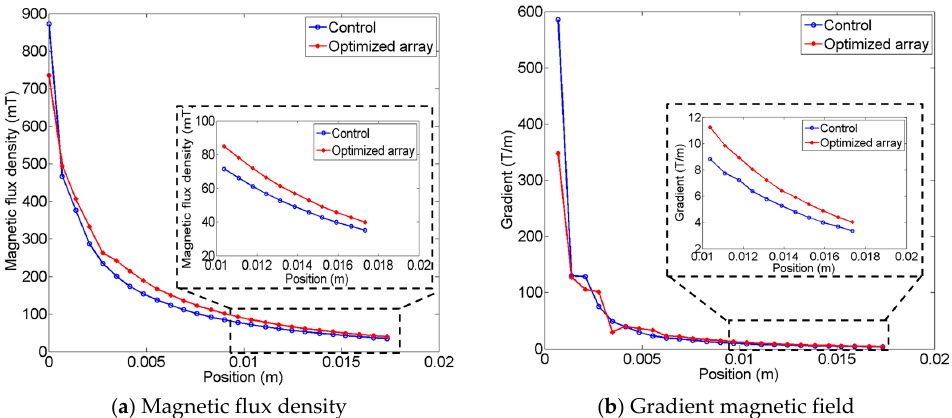
Figure 6. Comparison of magnetic flux density and gradient magnetic field for the initial magnetic array and the optimized magnetic array. The blue line indicates the initial configuration, and the red line represents the optimized array. ( a ) Magnetic flux density. ( b ) Gradient magnetic field.